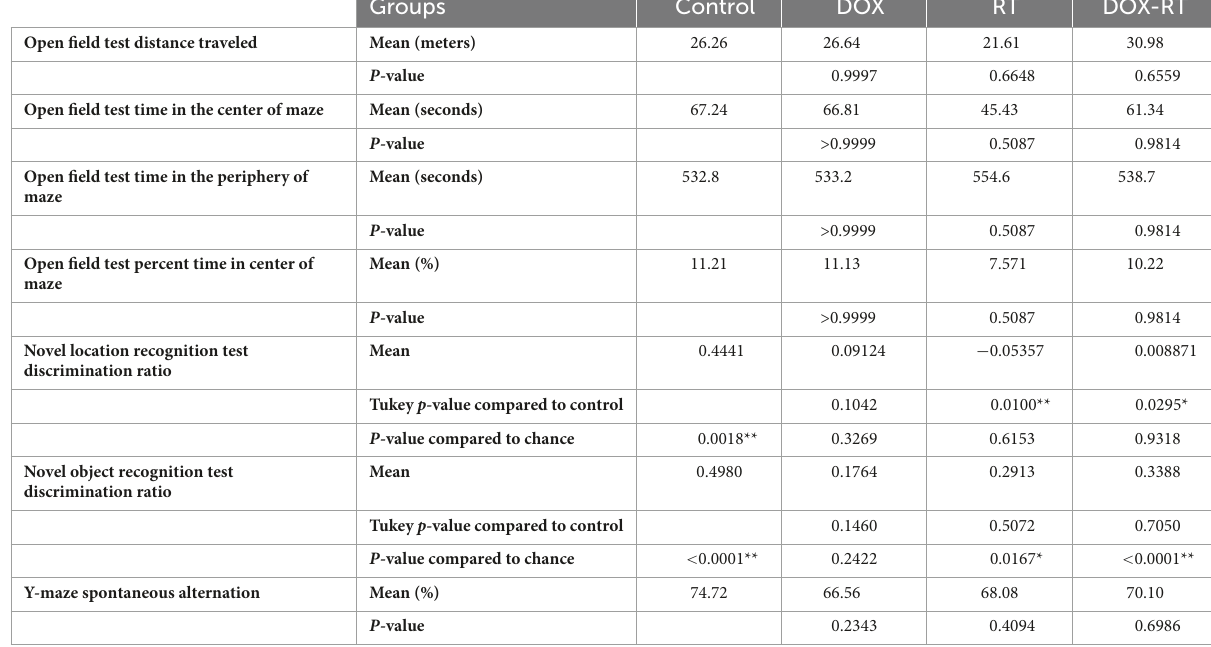
TABLE 1 Behavioral test results.